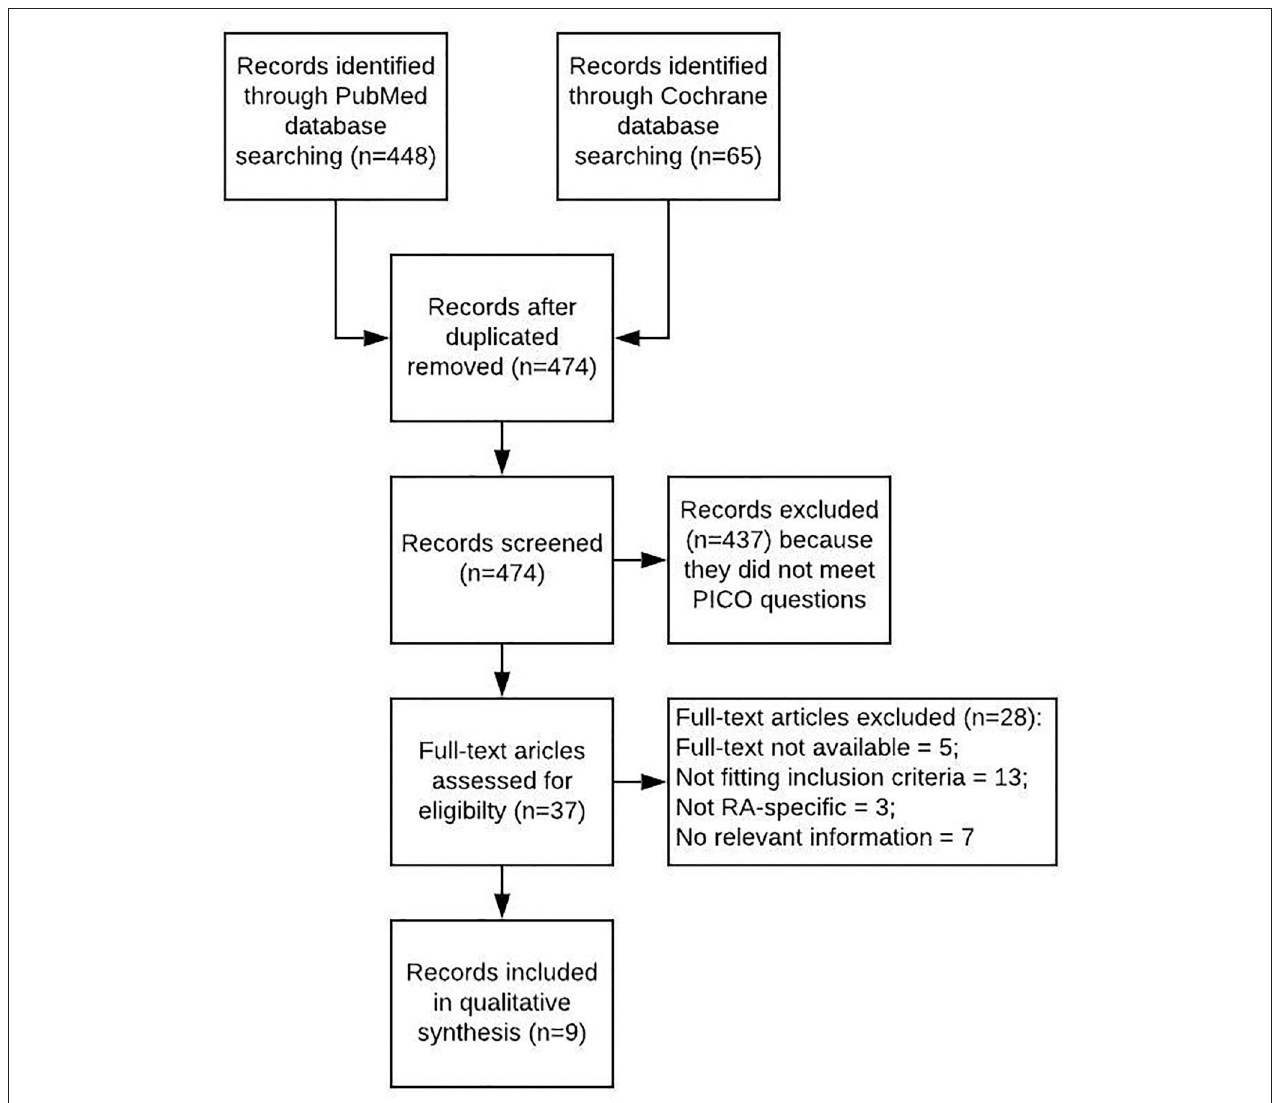
FIGURE 1 | Flowchart picturing the process of the